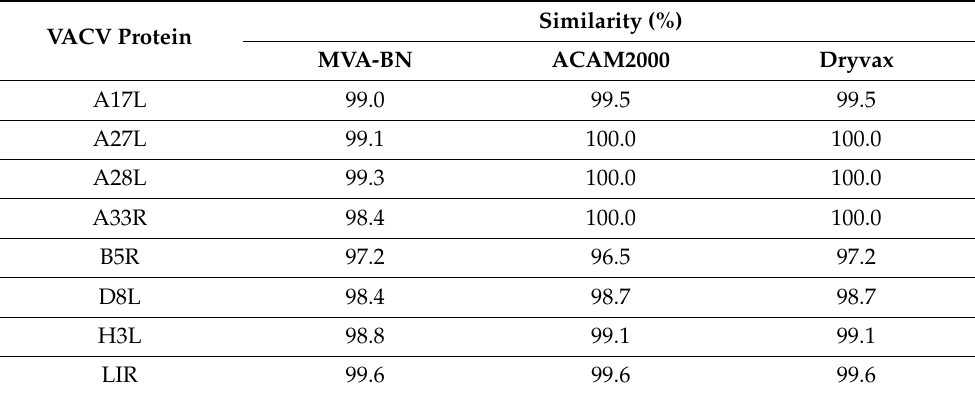
Figure 2. MPXV-2022 does not comprise any new mutations relative to the MPXV-CB reference sequence in the epitopes of the known D8L-specific antibodies. Mutations observed in MPXV-2022 and MPXV-CB are mapped on the epitope of the three known neutralizing antibodies (VACV-66, VACV-138, and VACV-304) in the D8L protein [PDB ID: 4E9O]. The structure of D8L is shown in gray, while mutations and their labels are colored according to the scheme in the legend. Table 3. Similarity of the VACV proteins known to be targets of NAbs with reference sequences for the MVA-BN, ACAM2000, and Dryvax